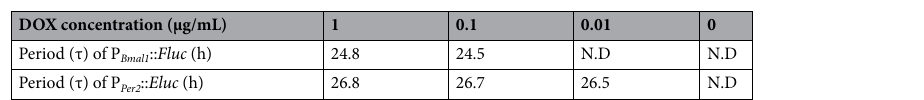
Table 2. Period of P Bmal1 :: Fluc and P Per2 :: Eluc oscillation calculated for each DOX concentration. The 0 to 141 h data shown in Fig. 2 were detrended by 6th-order polynomials and subjected to chi-square periodogram analysis using Lumicycle analysis software (ActiMetrics; Wilmette, IL, USA).